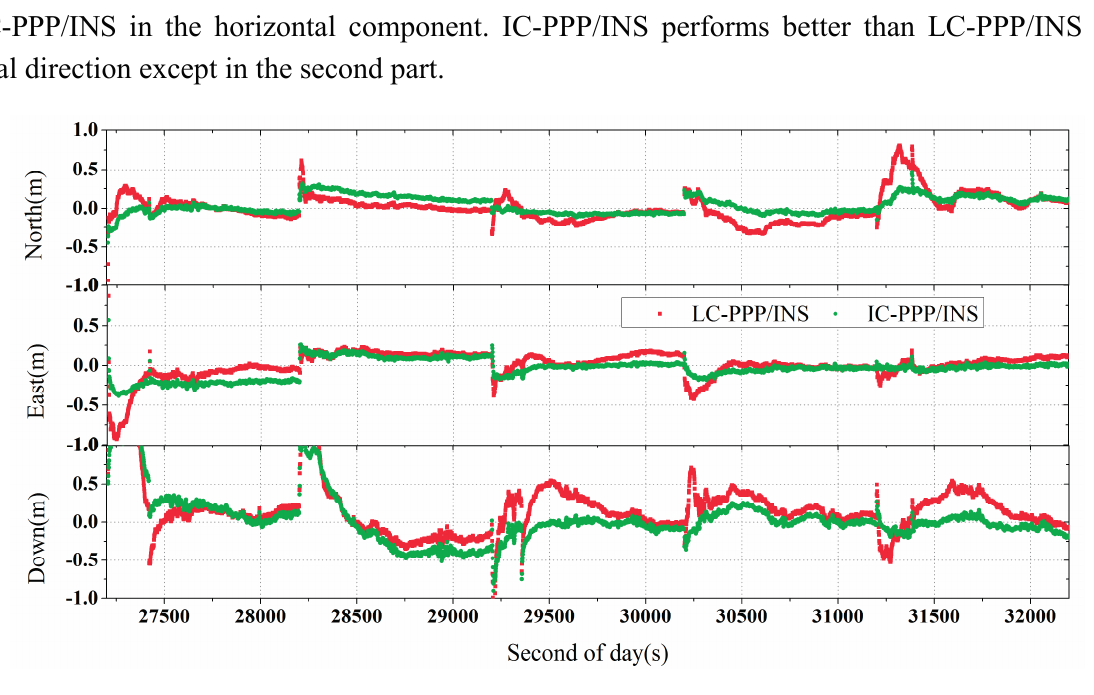
Figure 7. Position differences of LC-PPP/INS and IC-PPP/INS ( red line) for PPP/INS ( green line) initialization